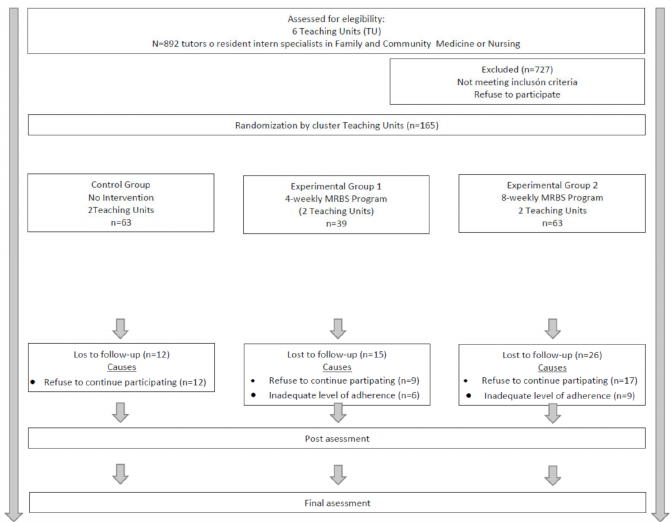
Figure 1. Flow-chart of the cluster-randomized trial and intervention